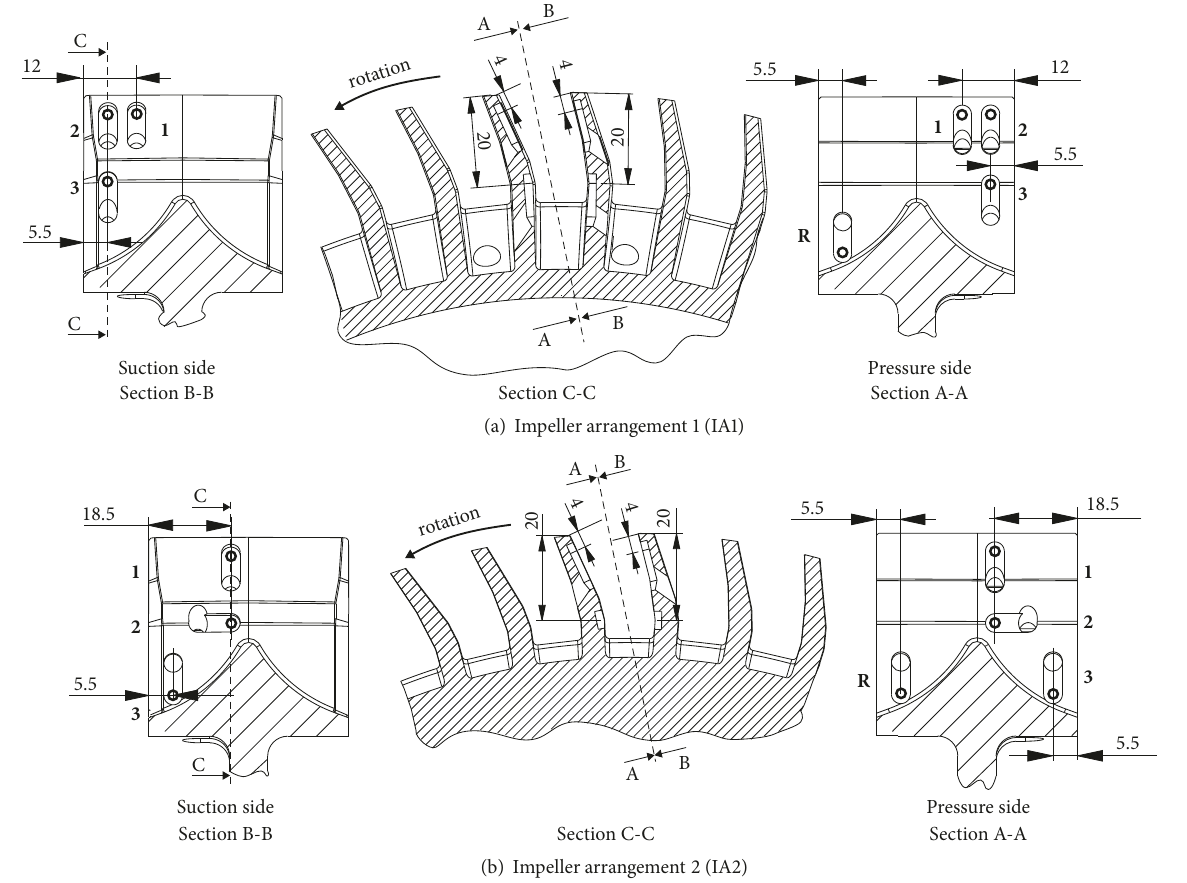
Figure 5: Positions of the pressure sensors (membrane position denoted by a black thick framed circle) in both impeller arrangements. Section B-B: view on suction side of the blade (SS); Section A-A: view on pressure side of the blade (PS). Sensor name in bold : example: impeller arrangement 1 (a) suction side of blade (left figure); Position 2 (sensor in the upper left corner of the blade):